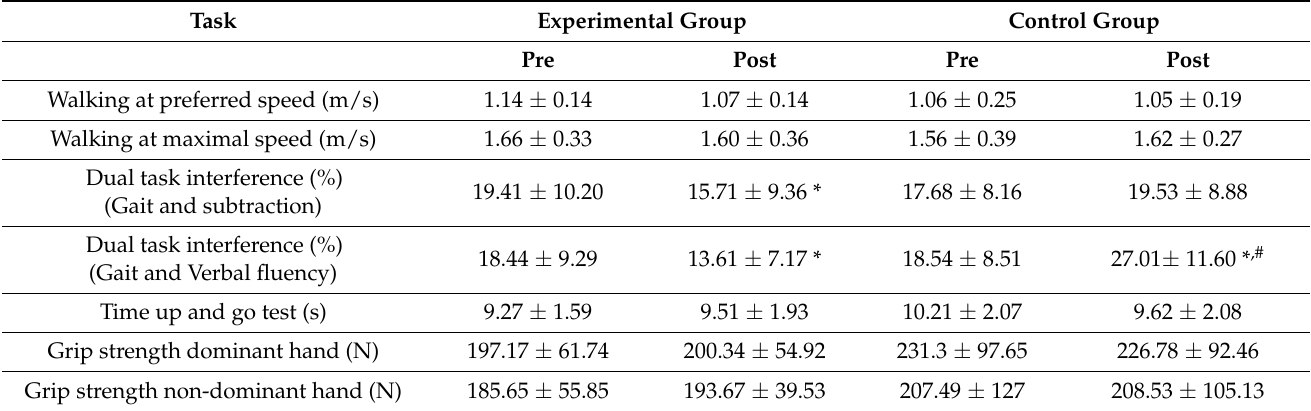
Post evaluations. The ANOVA showed significant interactions (group*time) for dual task interfer- ence during the subtraction condition (F = 4.81, p = 0.042; η 2 = 0.22; observed power (OP) = 0.55) without significant group and time effects. Post hoc analysis indicated a sig- nificant reduction ( p = 0.02) for the dual task interference only in the GE after the exercise program (Figure 2a). There were no significant differences between groups at Pre and